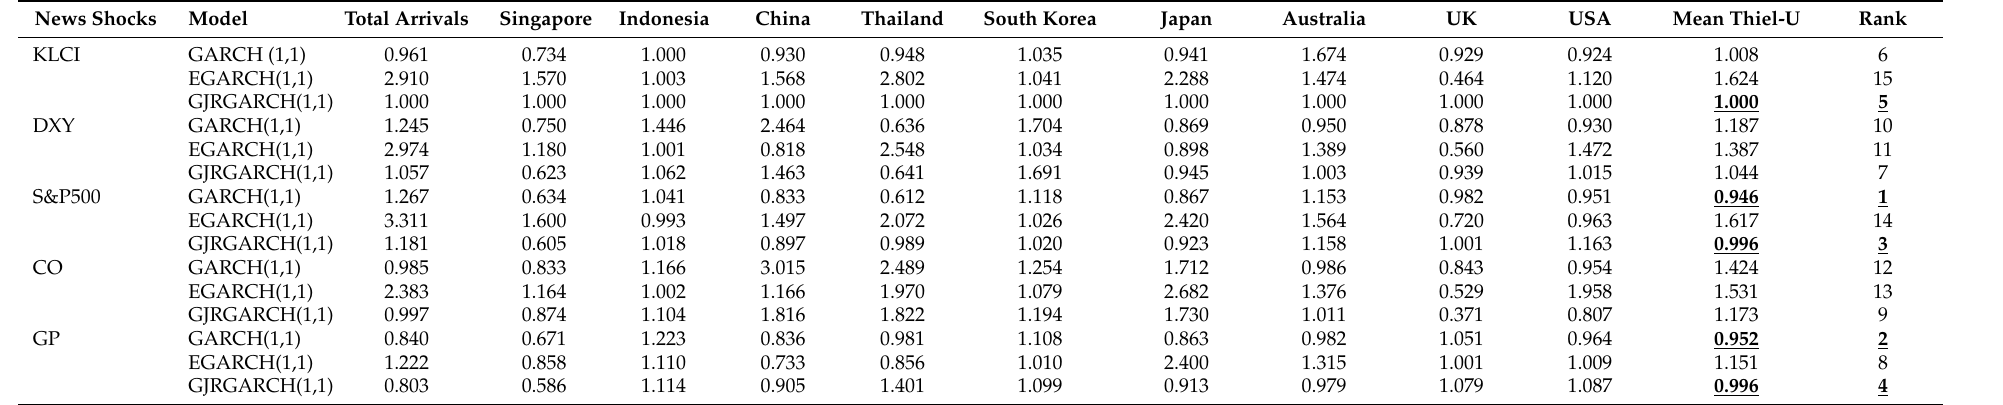
Table 12. Tourism demand volatility forecasting methods based on MAE for out-of-sample one-step-ahead forecasting. News